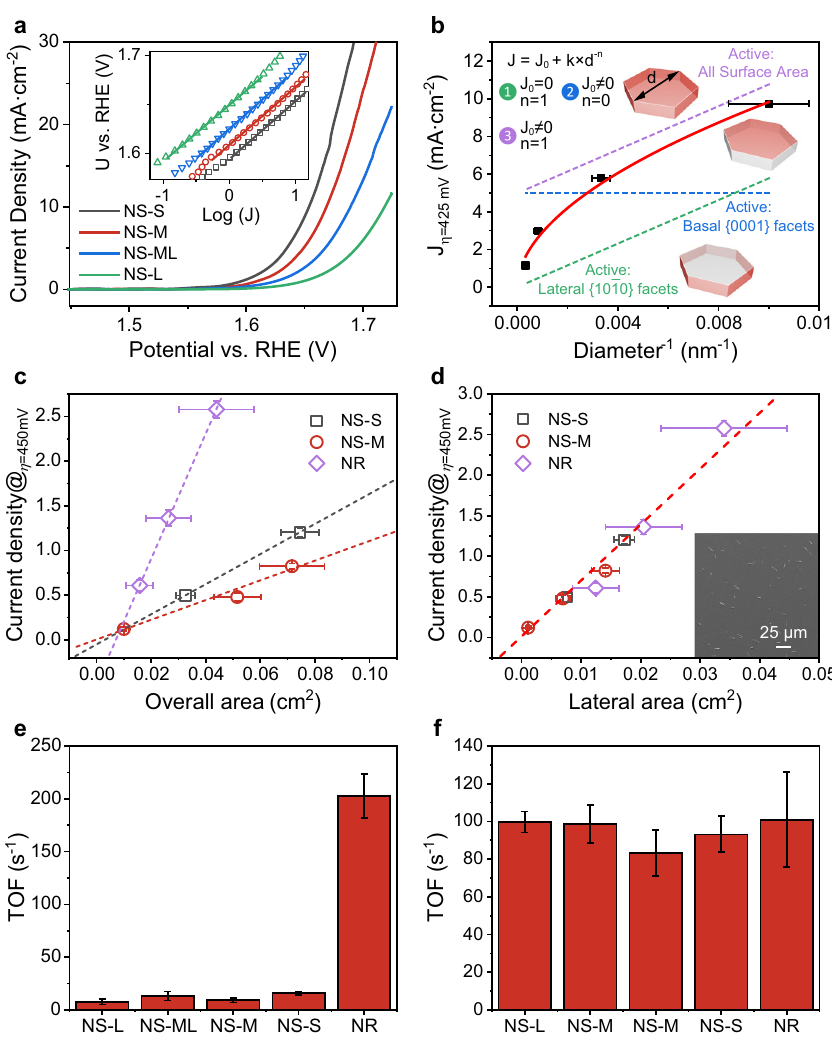
Fig. 4 | Catalytic activities of CoOOH NR and CoOOH NS for oxygen evolution reaction. a Polarizationcurves of NS-S (black), NS-M(red), NS-ML (blue),and NS-L (green).TheinsetshowsthecorrespondingTafelplots; b Size-dependentactivities of NS at the same loadings; c , d Correlation of the current densities with c the overallsurfaceareasand d thelateralfacetareas.NS-Sisdisplayedinblack,NS-Min red, and NR in purple. The inset in ( d ) is the SEM image of NR spin-coated carbon